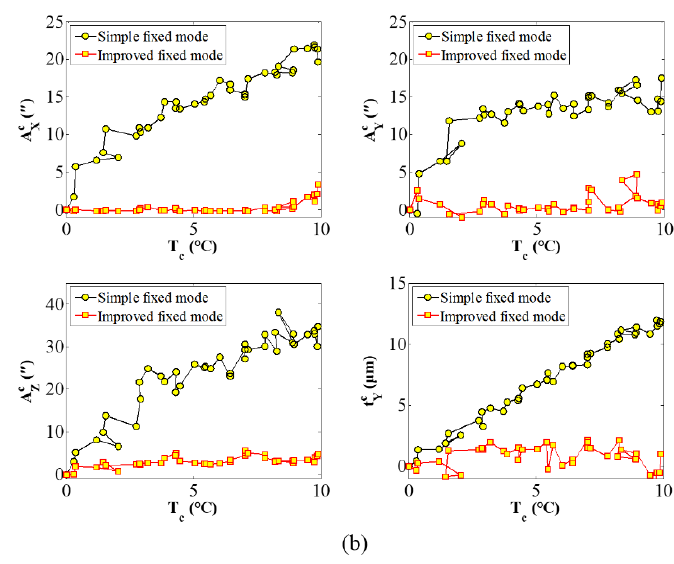
Figure 5. Experimental investigation of thermal behaviours of the camera case under different fixed modes: ( a ) schematic of experimental setup, and ( b ) variation in thermal behaviours with the temperature of the camera case.